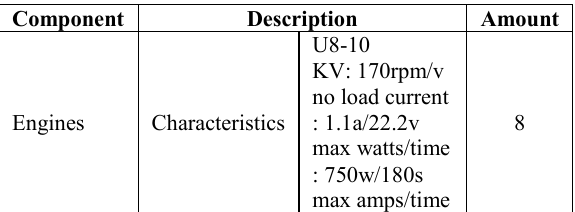
Table 4. Technical specifications of the drone